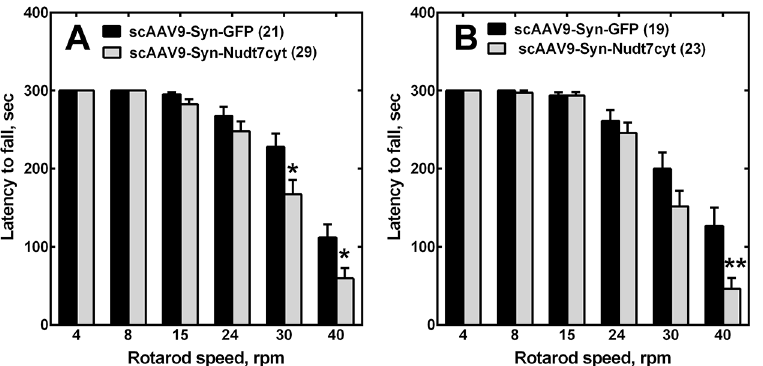
Fig 4. Reduced motor coordination in mice with neuron-specific overexpression of Nudt7cyt. Mice were analyzed for their performance on the rotarod test at (A) 9 and (B) 17 weeks of age after injection of the AAV9 particles at P1. Numbers in parentheses indicate the number of animals used for the measurement. Data are reported as the mean ± the standard error. * , p < 0.05; ** , p < 0.01.